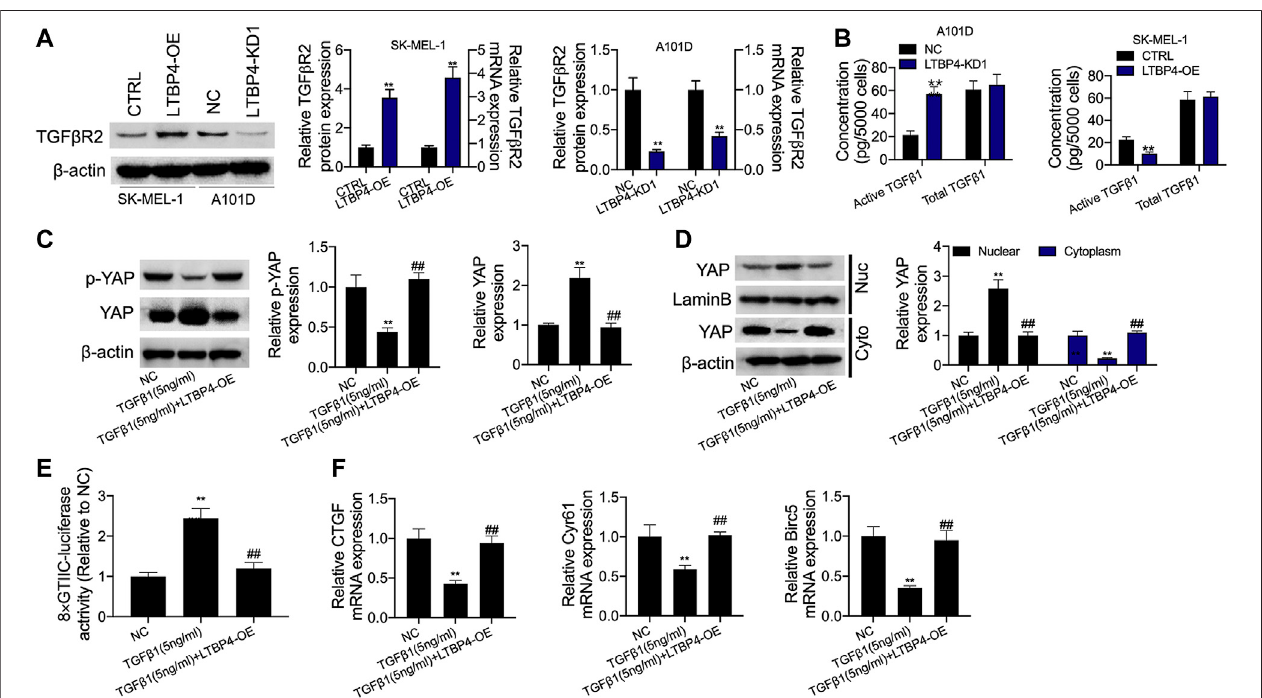
FIGURE 8 | LTBP4 suppressed secretion of active TGF β 1 as well as active TGF β 1-stimulated YAP1 nuclear-cytoplasmic translocation and the Hippo signaling inhibition. (A) Western blot, RT-PCR and ELISA analysis of TGF β RII expression (A) and total and active TGF β 1 (B) in shRNA-LTBP4#1 transfected SK-MEL-1 cells and LTBP4 expressing plasmids transfected A101 cells. A101D cells transfected with pcDNA3.1-LTBP4 were treated with 5 ng/ml TGF- β 1, then, western blot analysis of YAP phosphorylation (C ), cytoplasmic YAP1 expression and nuclear YAP1 expression (D) , the luciferase activity of 8xGTIIC-luciferase analysis of YAP1 transcriptional activity (E) , and RT-PCR analysis of CTGF, Cyr61, and Birc5 expression (F) . β -actin and LaminB were used as a load control. Data are presented as the mean ± standard deviation. ** p < 0.01 vs CTRL/or NC group.